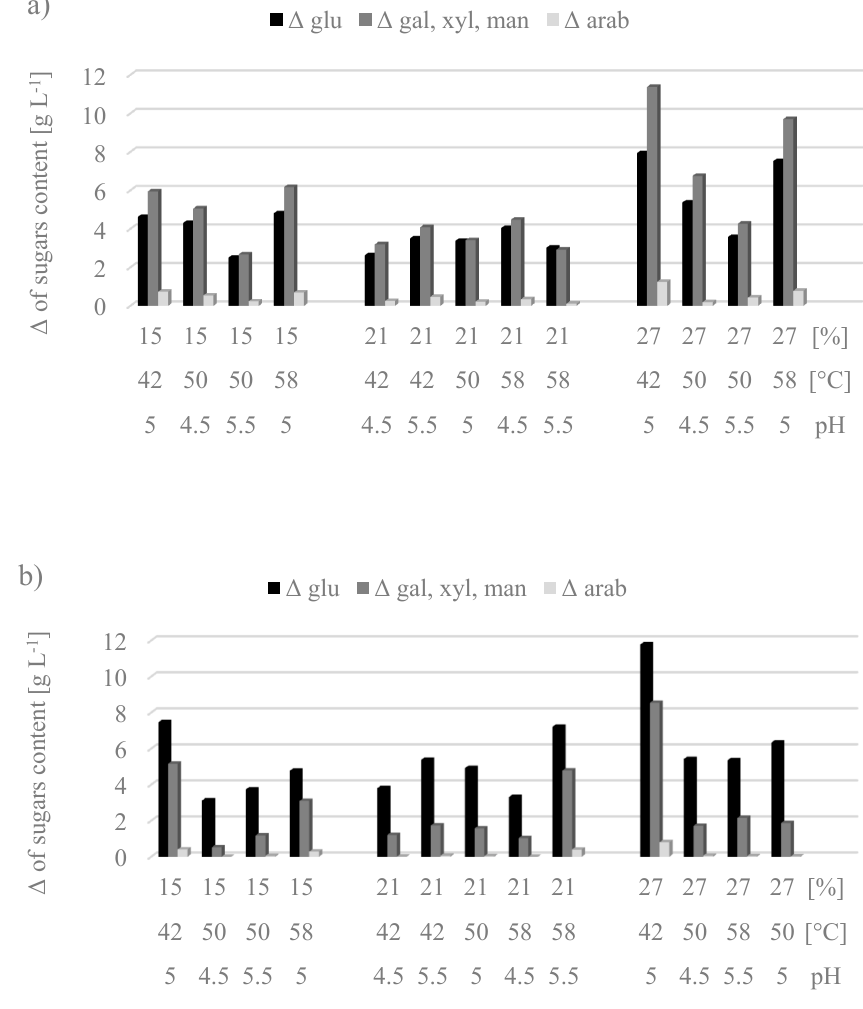
Figure 1. Comparison of changes in sugar content after the hydrolysis step conducted under various conditions (substrate concentration, temperature, pH) with ( a ) C1 and ( b ) CTec2 enzymes.